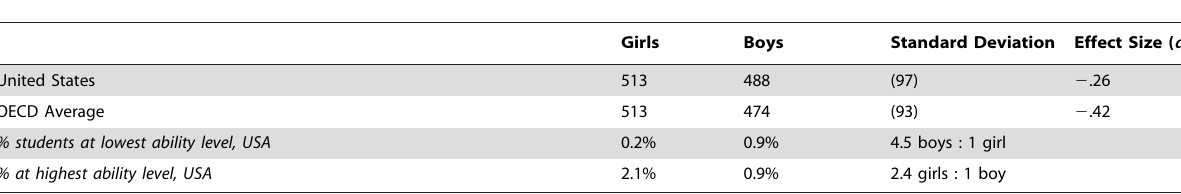
Table 5. Reading Ability for Girls and Boys for the USA and OECD nations.